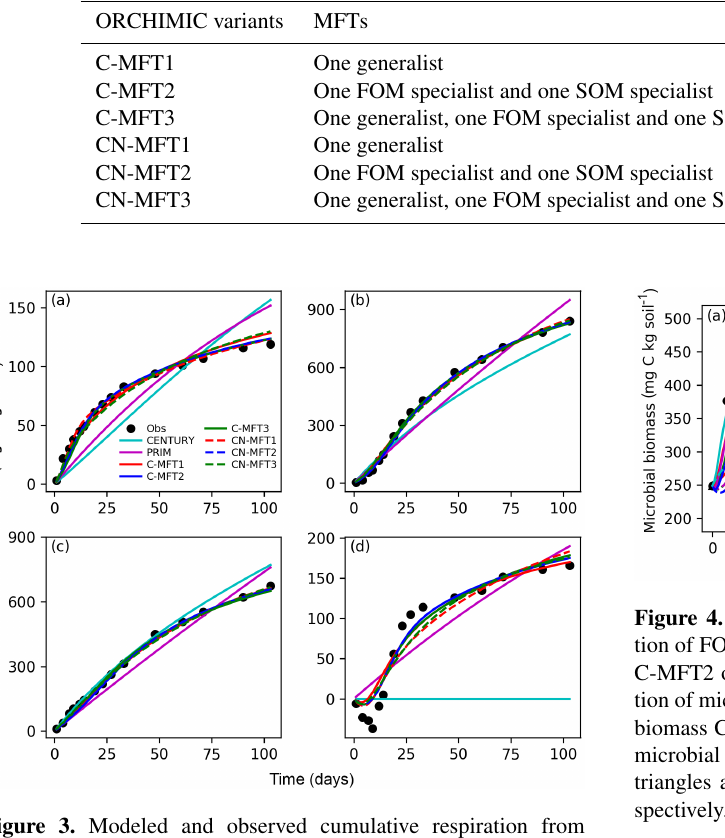
Figure 3. Modeled and observed cumulative respiration from (a) FOM, (b) SOM with FOM addition, (c) SOM without FOM addition and (d) priming effect (difference between measured SOM derived respiration with FOM addition minus without FOM addi- tion) (C-MFT2 overlapped with CN-MFT2).